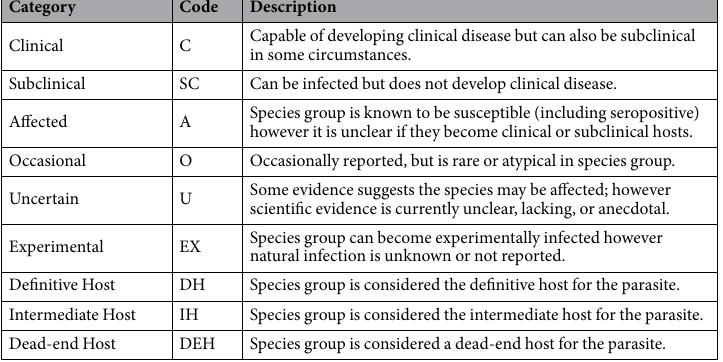
Table 1. Susceptibility categories used to describe infection in the host species. Categories were established a-priori and used to denote the potential impact in each of these species based on available scientific